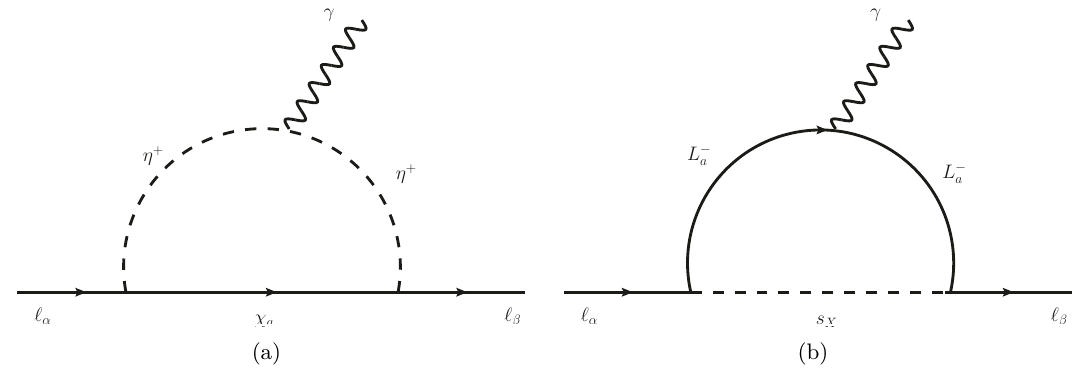
Figure 3 . Diagrams contributing to lepton ( g − 2) and ‘ α → ‘ β γ